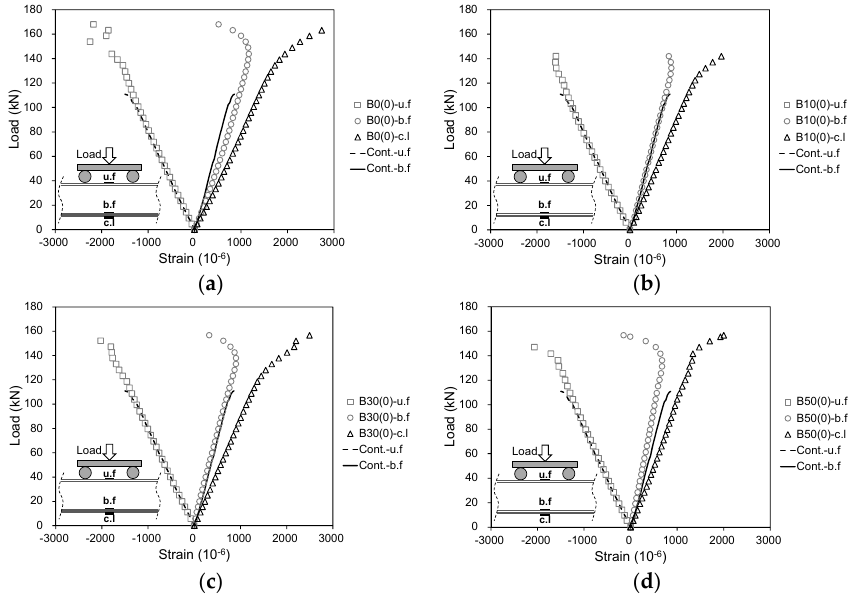
Figure 7. Load-strain responses of beams tested at zero days: ( a ) Beam B0; ( b ) Beam B10; ( c ) Beam B30; ( d ) Beam B50.